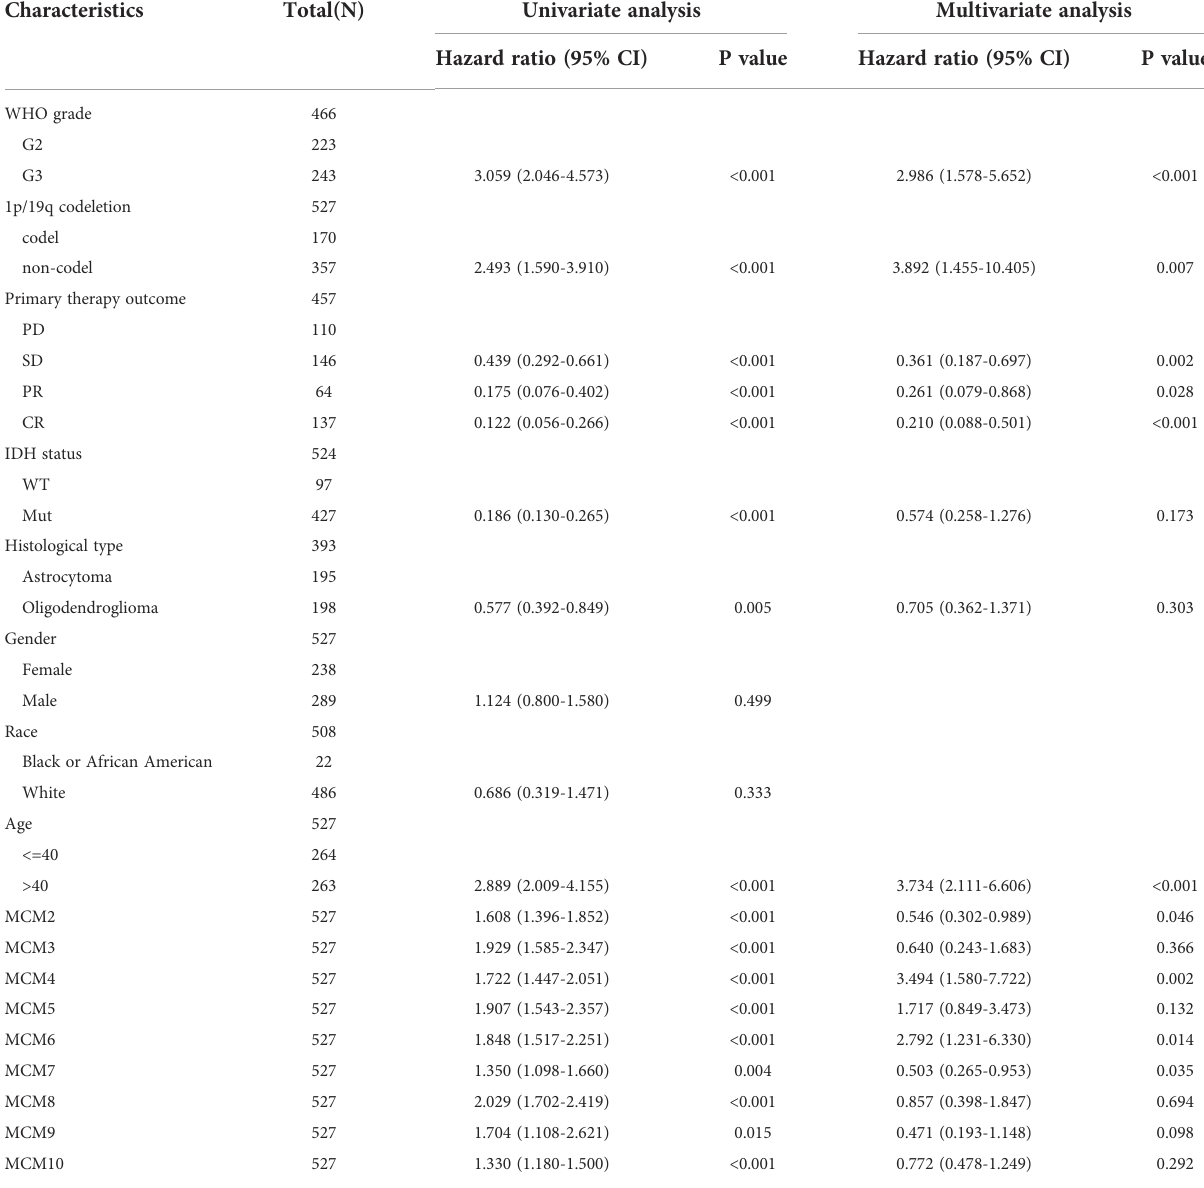
TABLE 1 Examine the prognosis of MCMs in glioma patients analysis by cox regression.